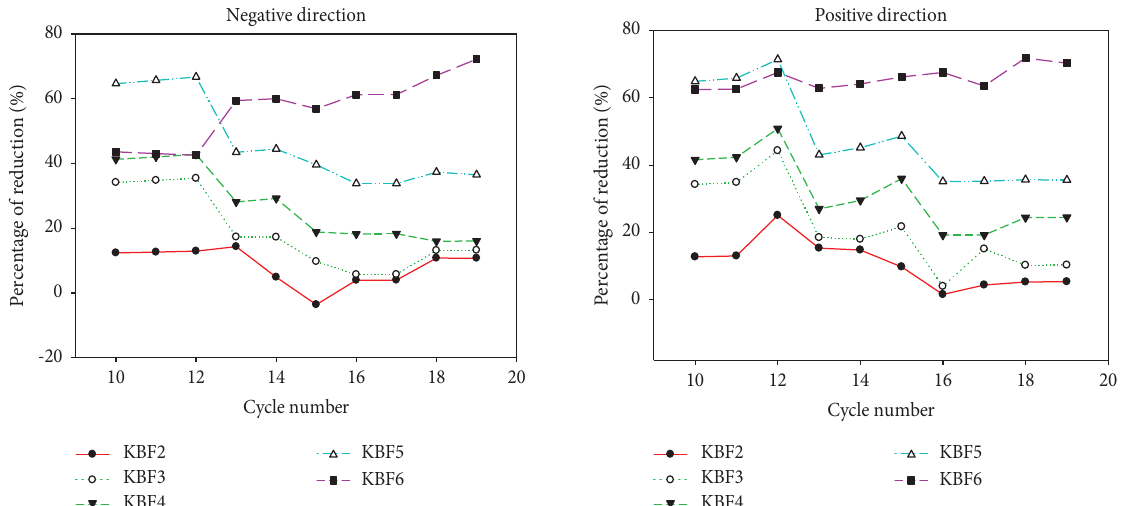
Figure 19: Te reduction of permanent deformation in positive and negative directions compared to KBF1.